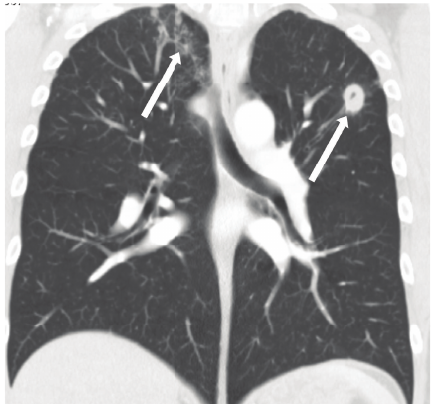
Figure 1: Abdominal X-ray at presentation showing hugely dilated caecum and transverse colon with paucity of gas in the descending colon.